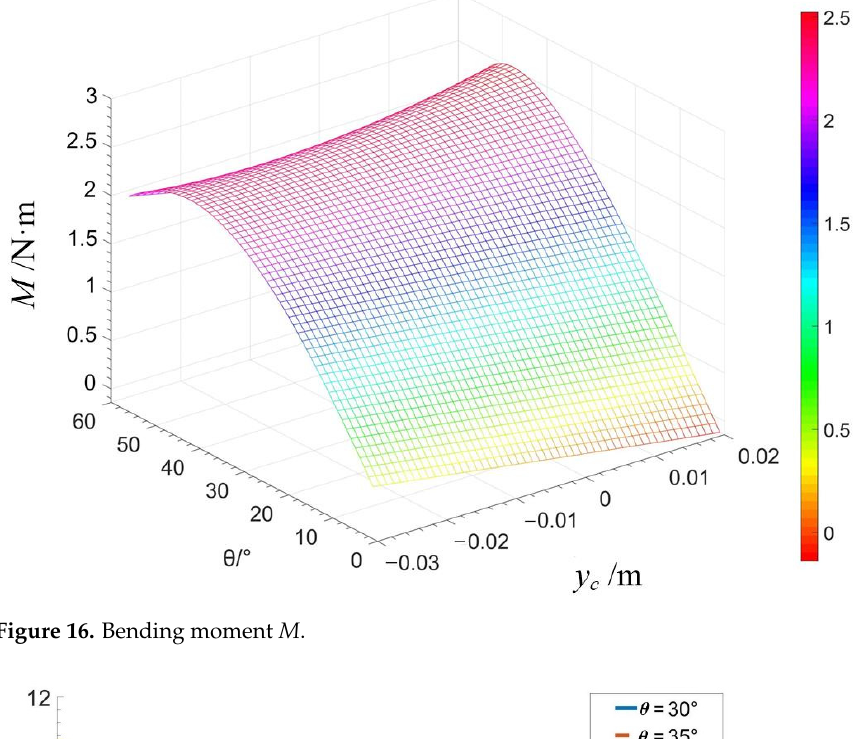
Figure 16. Bending moment M .